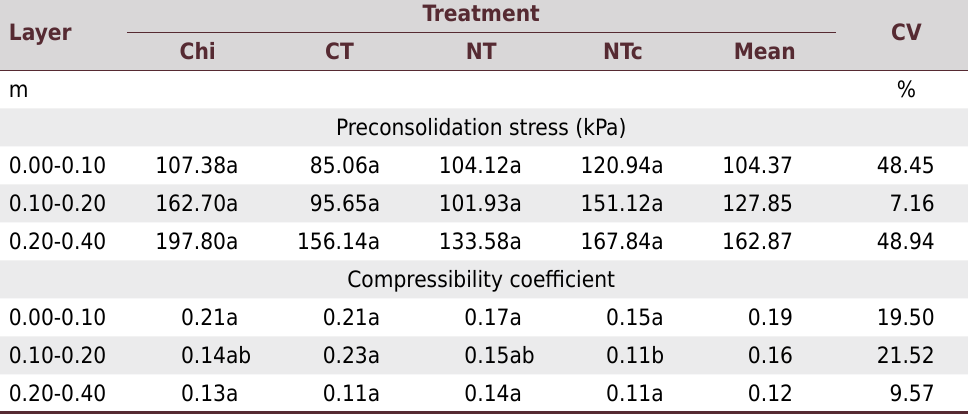
Table 4. Soil preconsolidation stress and compressibility coefficient in three soil layers and four tillage methods one month after planting of the cassava crop Layer